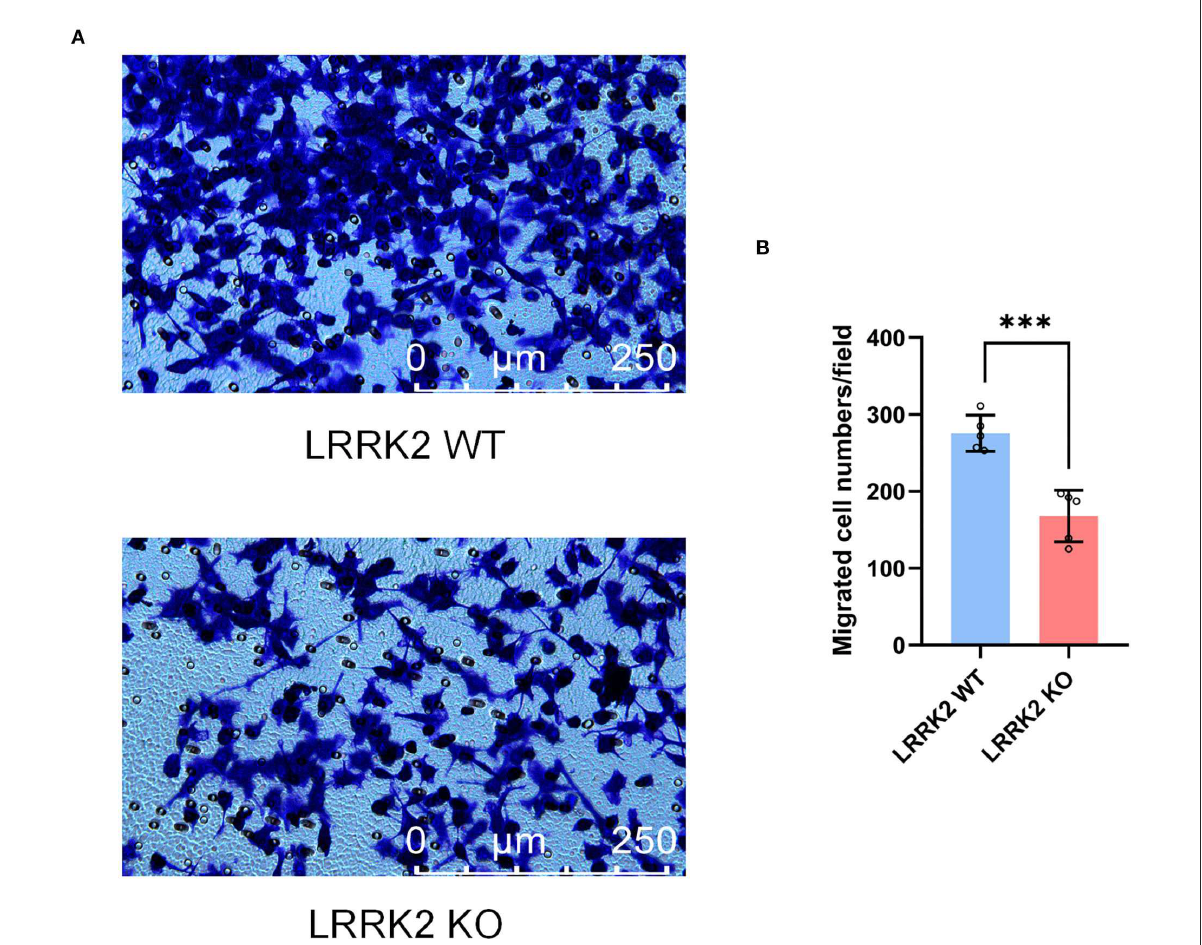
FIGURE5 Microglial motility is retarded by LRRK2 knockout. (A) Effects on microglial migration after LRRK2 knockout, as assessed by the Transwell migration assay. (B) Statistical analysis of migrated cell numbers in (A) ( n = 5 experimental replicates, *** p < 0.001).